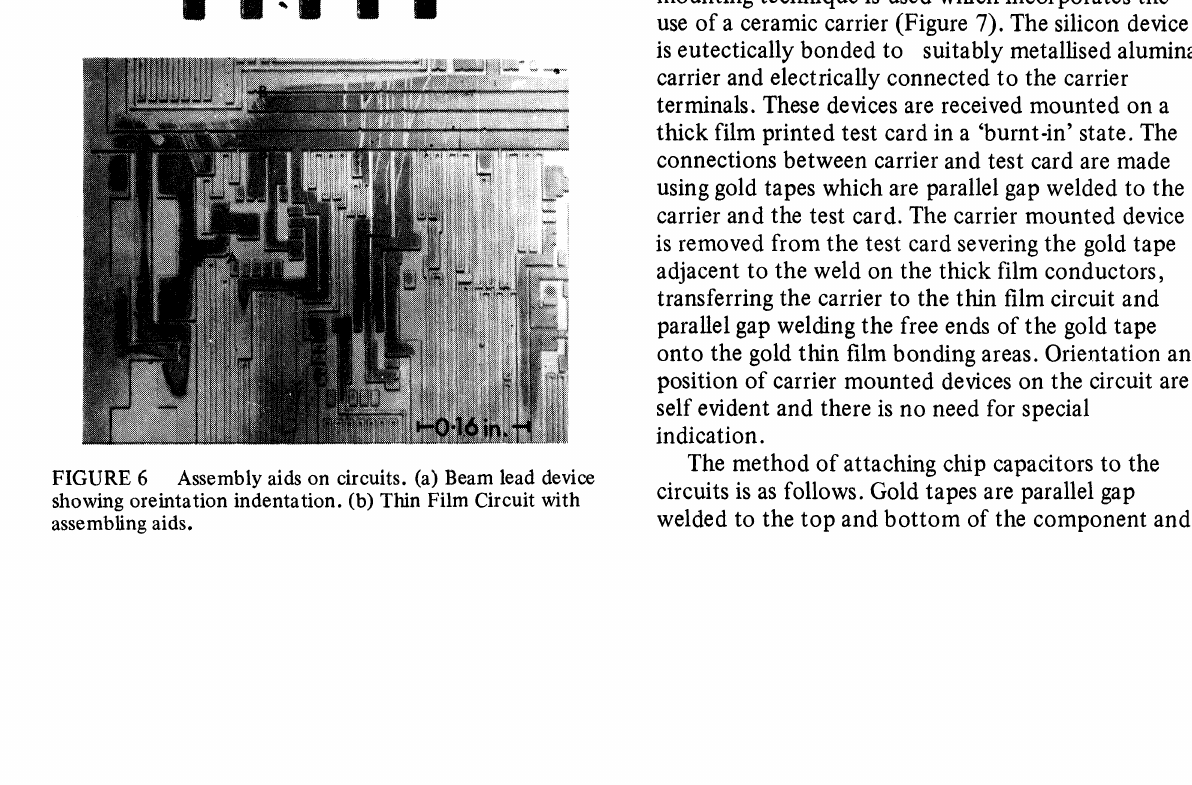
Assembly aids on circuits. (a) Beam lead device showing oreintation indentation. (b) Thin Film Circuit with assembling